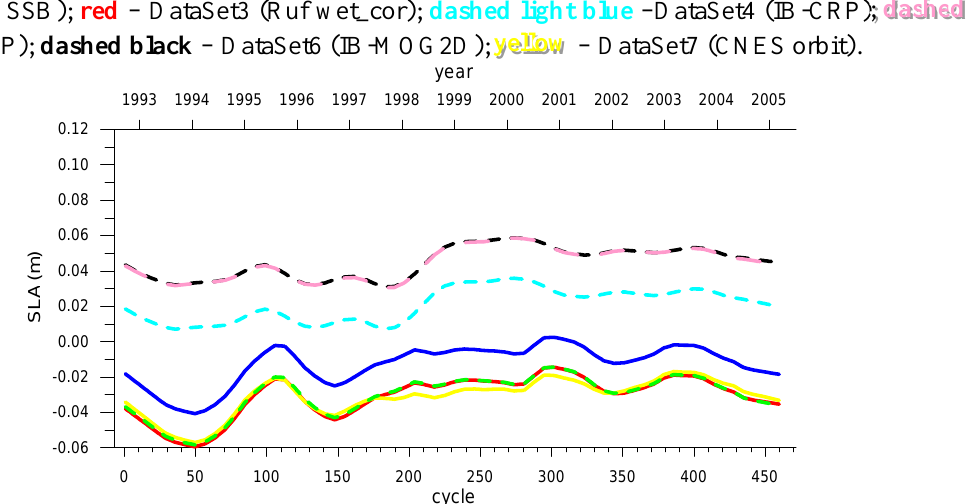
Figure 10b. Interannual variation of sea level for the Sub-Tropical region. dashed green – DataSet1; blue – DataSet2 (Labroue SSB); red – DataSet3 (Ruf wet_cor); dashed light blue –DataSet4 (IB-CRP);;; dddaaassshhheeeddd pppiiinnnkkk – DataSet5 (IB-VRP); dashed black – DataSet6 (IB-MOG2D); yyyeeellllllooowww – DataSet7 (CNES orbit).